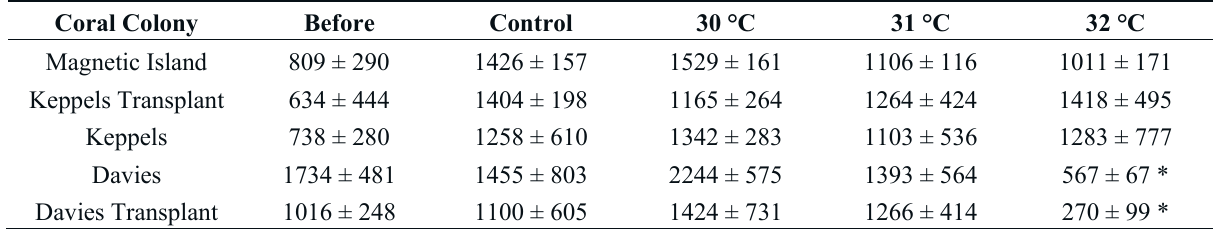
Table 3. Areal DMSP concentrations (nmol cm − 2 ) in colonies of native and transplanted Acropora millepora colonies exposed to before, control, 30 °C, 31 °C and 32 °C treatments. Coral Colony